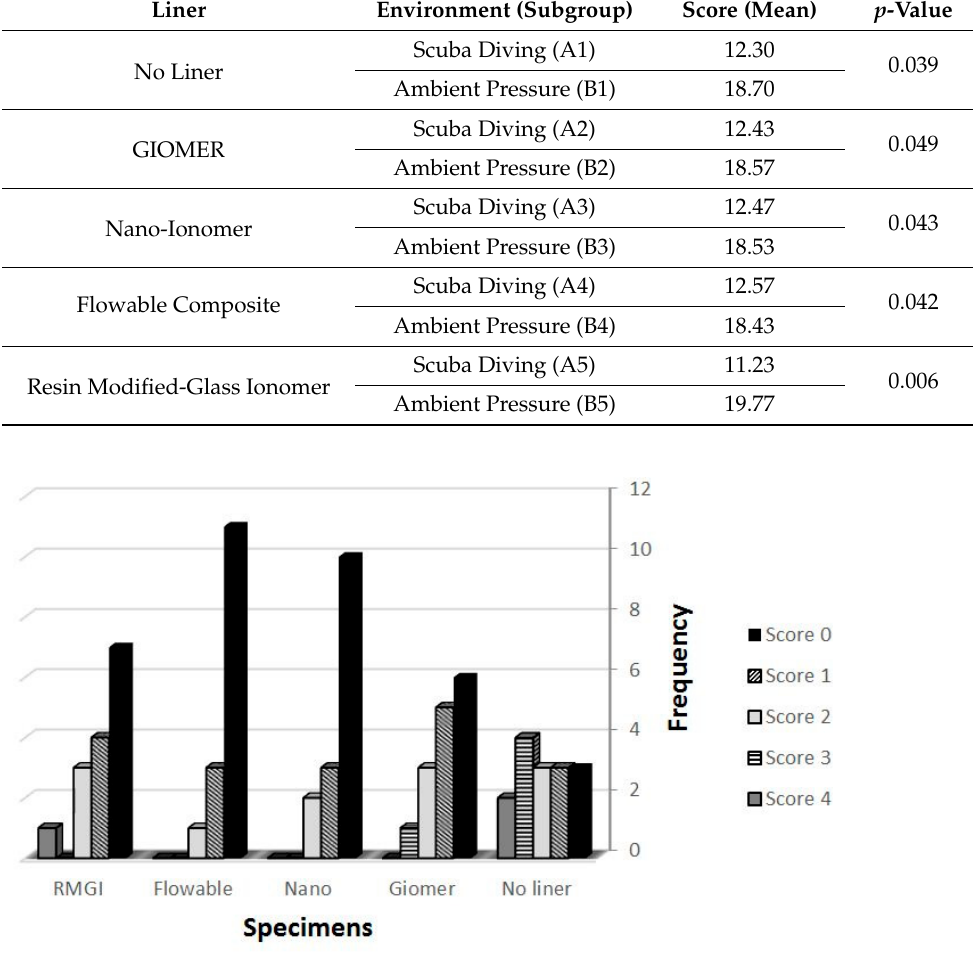
Figure 2. The frequency of microleakage scores in the specimens of group A.